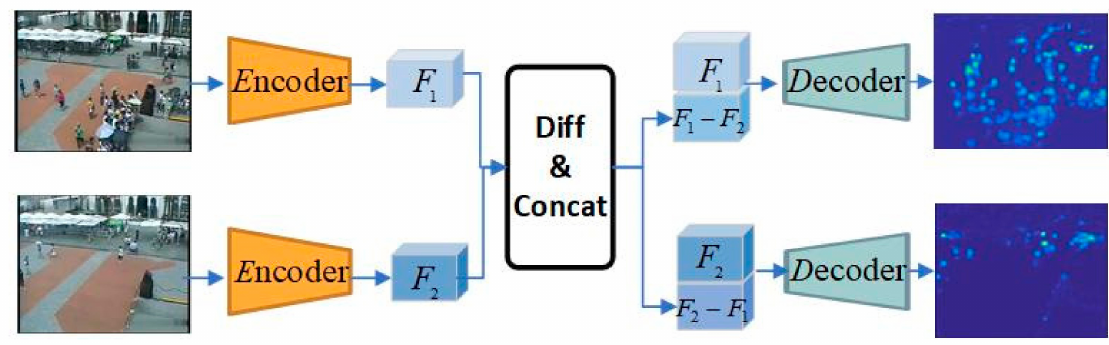
Figure 2. Two-stream network to capture